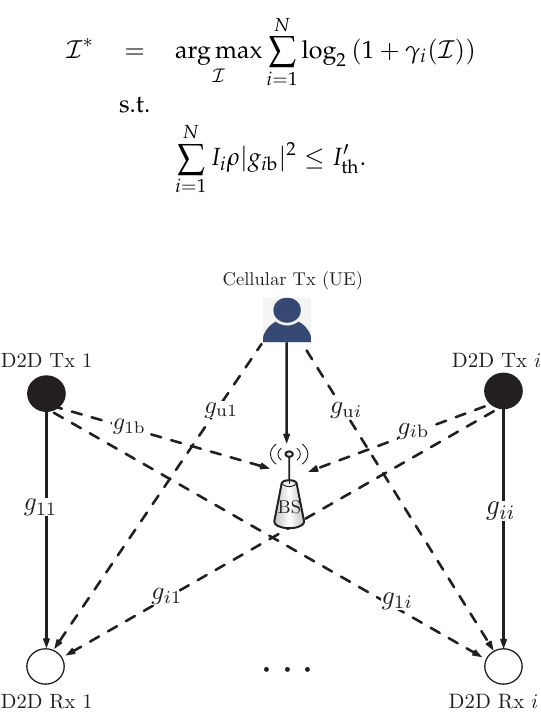
Figure 1. An underlaid device-to-device (D2D) communication